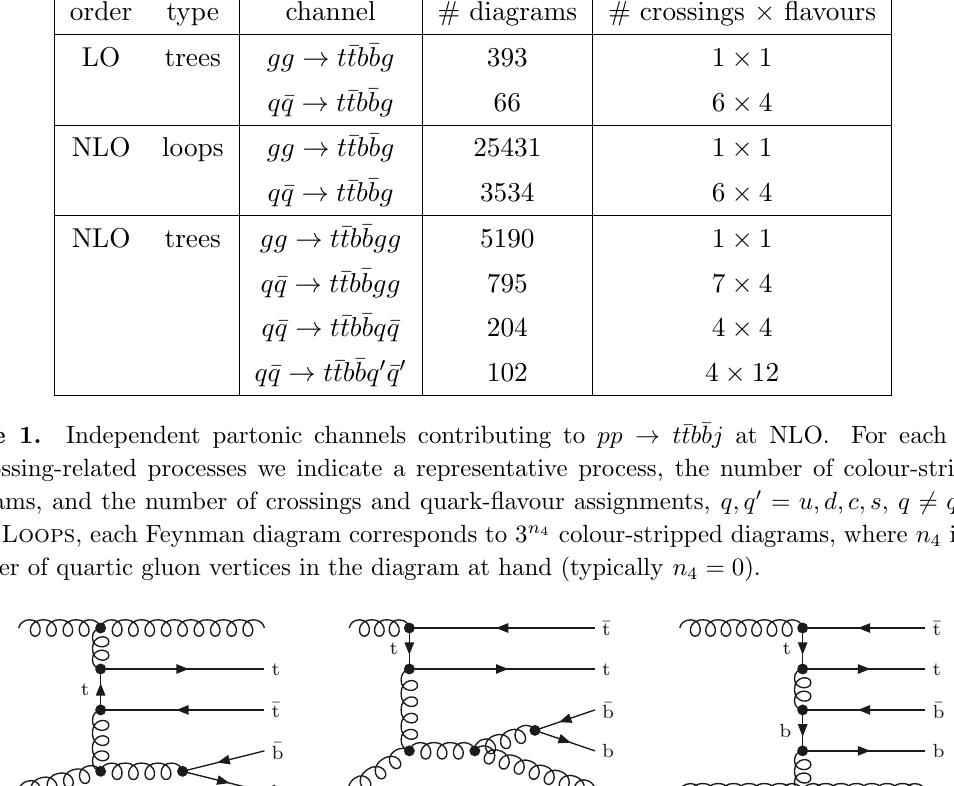
t (cid:22) tb (cid:22) bg !